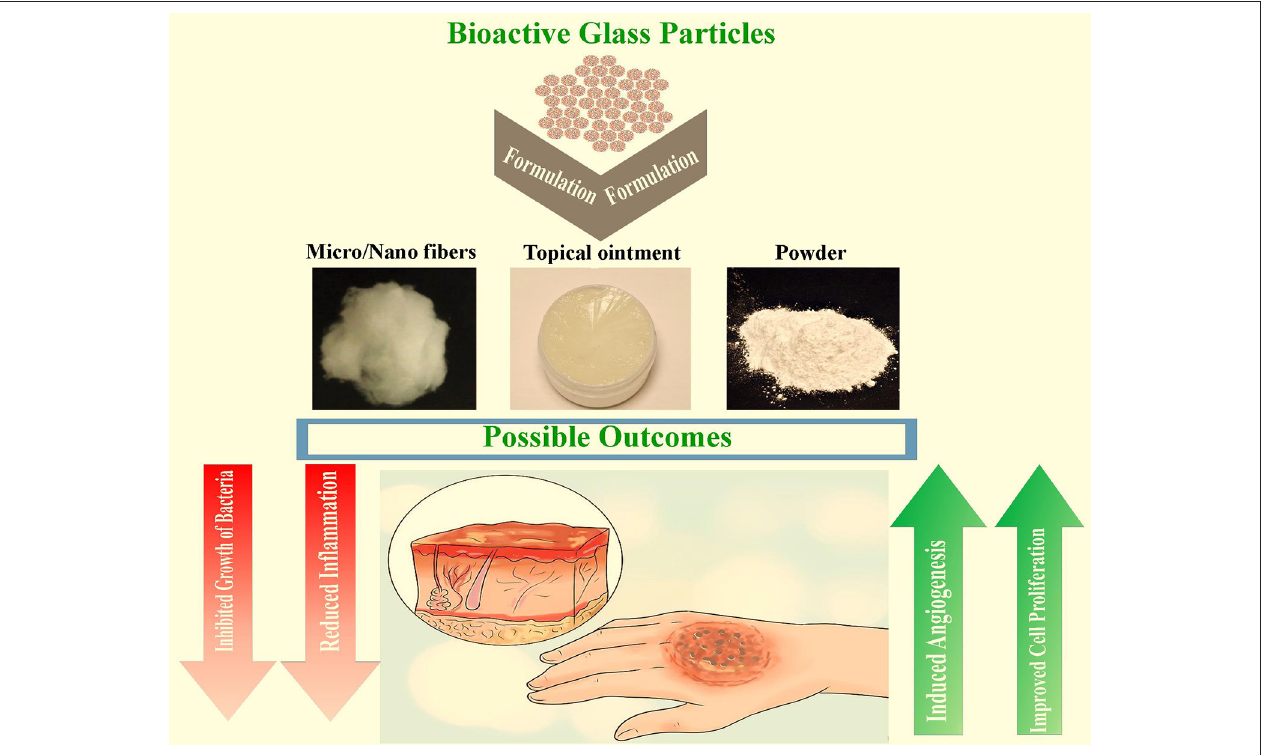
FIGURE 4 | Schematic representation of possibilities of BGs for the treatment of burns. With some modifications from Homayoon